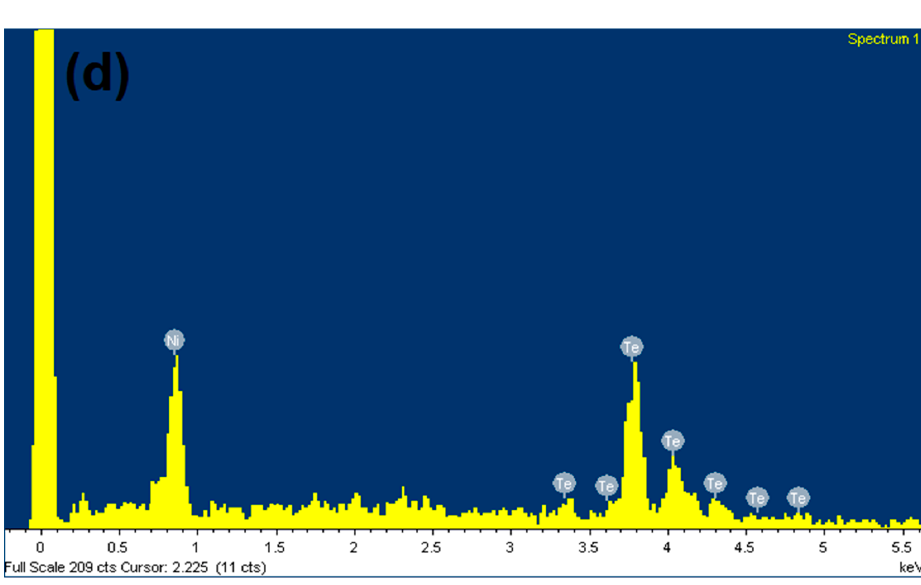
Figure 4. SEM images of ( a ) NiTe after 8 h milling time, ( b ) NiTe 2 after 12 h milling time, and ( c ) Ni 2 Te 3 after 12 h milling time. Figure 4 ( d ) represents the compositional analysis of the NiTe sample. TEM images of NiTe (a), NiTe 2 (b), and Ni 2 Te 3 (c) nanoparticles, obtained by mechan-